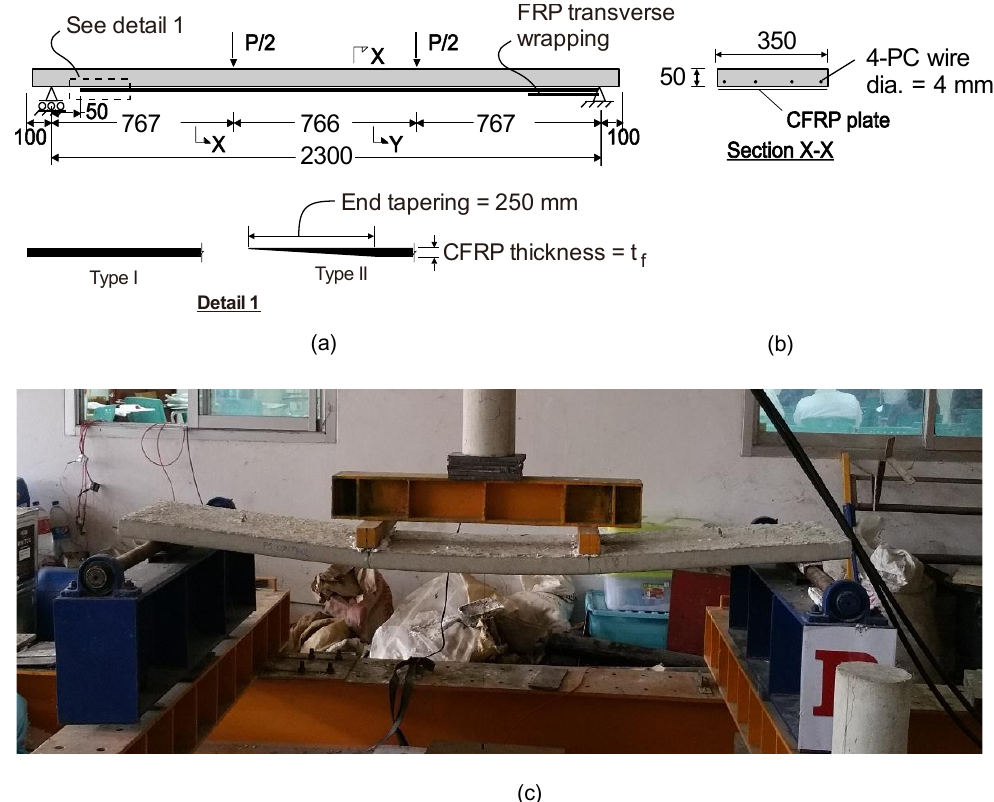
Figure 3. ( a ) Elevation and ( b ) cross section of slabs tested in four-point bending and ( c ) view of slab during